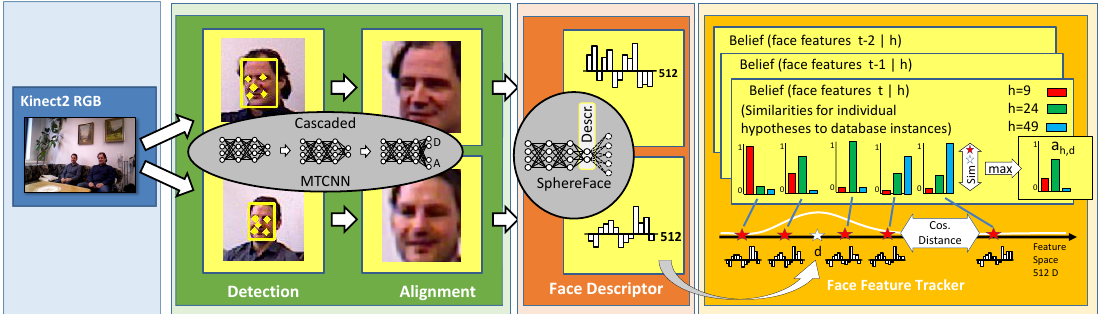
Figure 3. Overview of face-based person detection and identification. Face descriptors extracted for each detected face in the image are used for finding the association probability of detection d to the hypotheses h in the tracker. Therefore, stored similarities (red, green, and blue bars) of hypotheses to the samples in the feature data base (red stars) get weighted by the cosine similarity of the detected descriptor (white star) to all the sample descriptors. The maximum of the weighted values is used as association probability in the tracker. New observations are used for updating the database and the belief of the new time step as